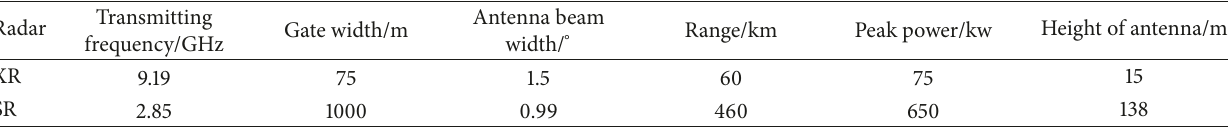
Table 1: Main characteristic values of the X-band radar and the S-band radar.